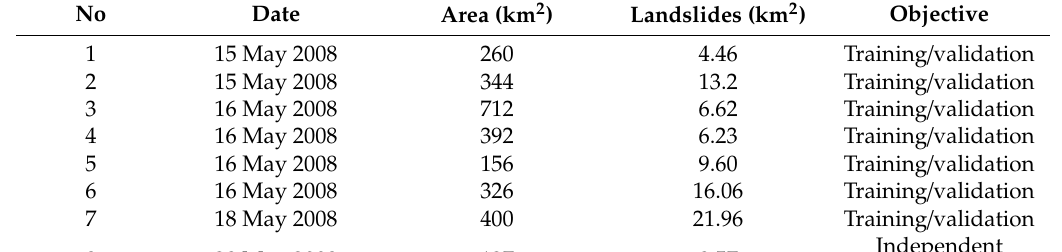
Table 1. The information of airborne images used for post-earthquake landslide identification.